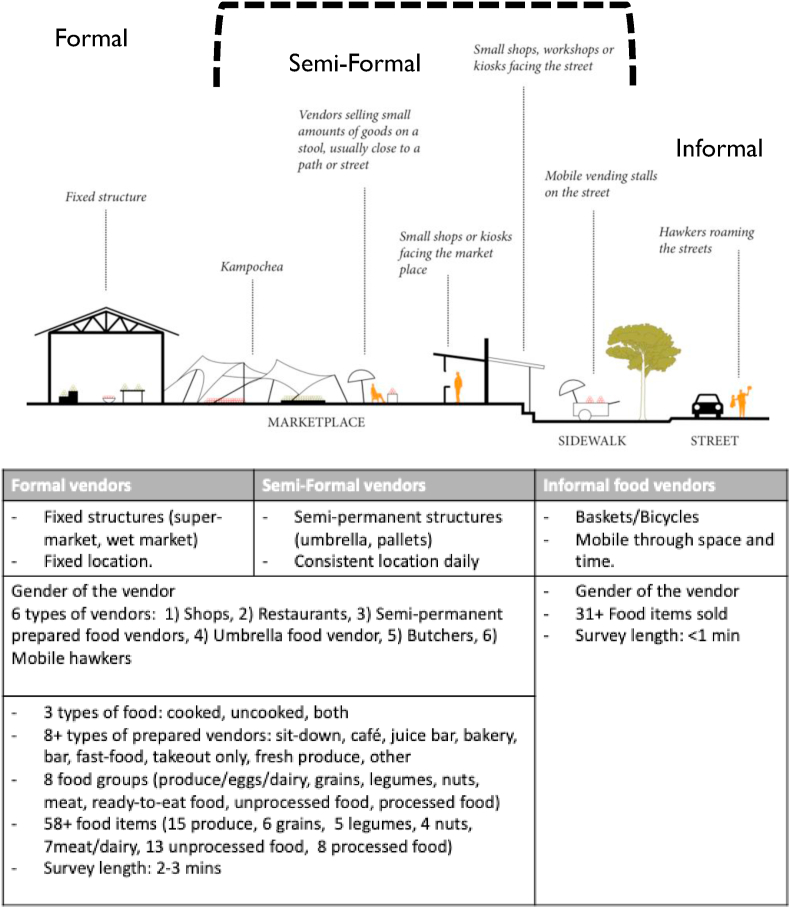
Illustration of food vendors grouped by formal, semi-formal, and informal categories in peri-urban Dar es Salaam, Tanzania. Criteria for grouping and type of information collected by vendor categories is summarized in table below. Illustration adapted from “Vendors Galore and More” (Boustedt and Mair, 2013).